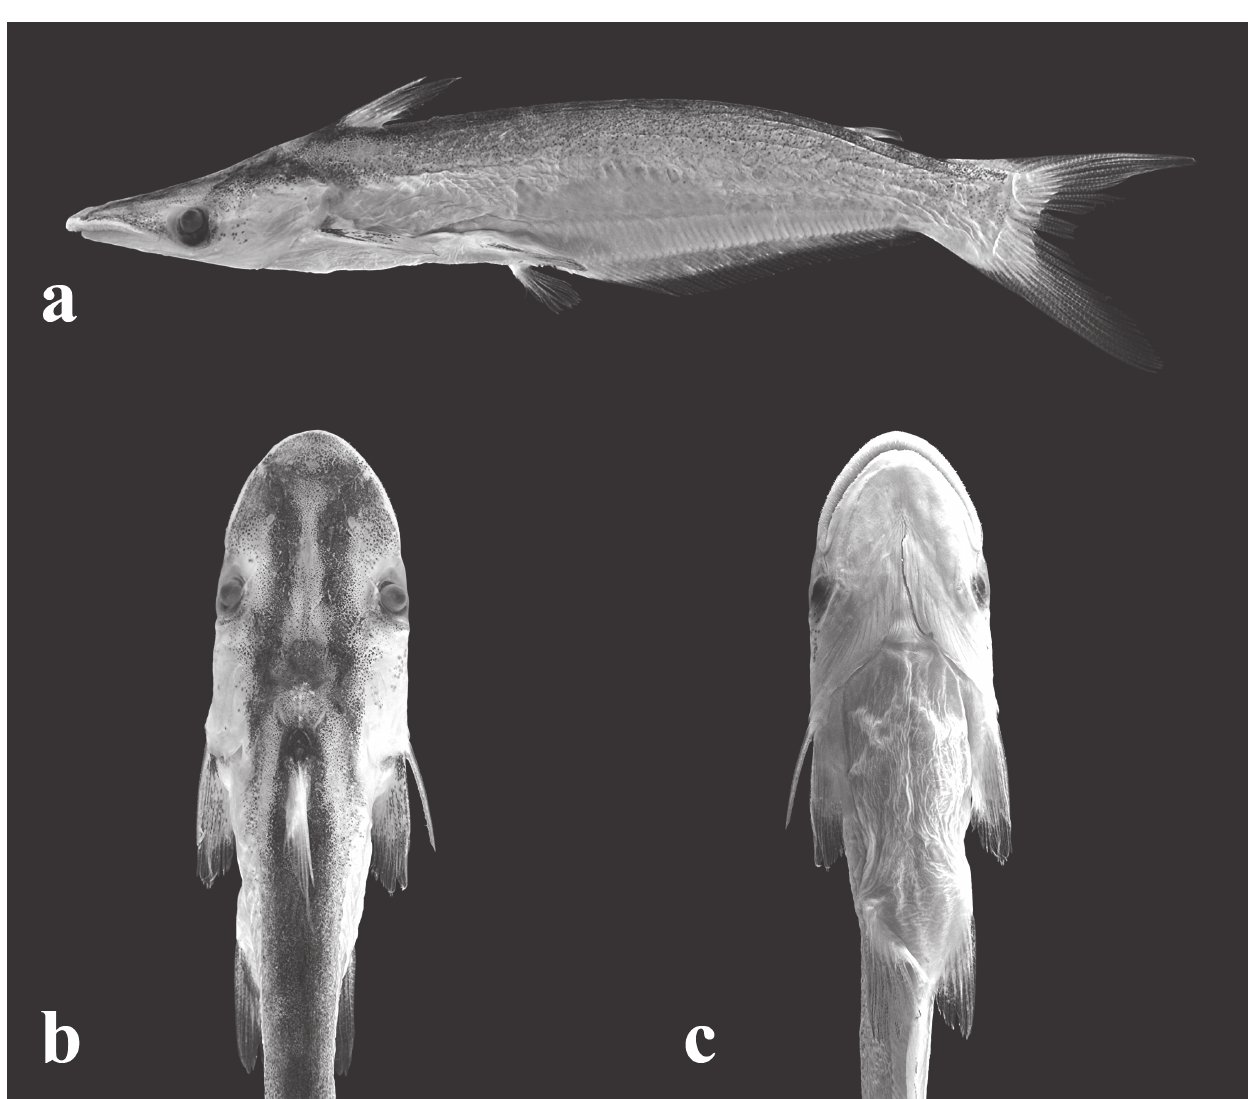
Fig. 1. Ageneiosus uranophthalmus , holotype, INPA 8945, 92.1 mm SL, Brazil, Amazonas State, Itacoatiara, rio Amazonas below Paraná da Eva, in lateral (a) , dorsal (b) , and ventral (c)